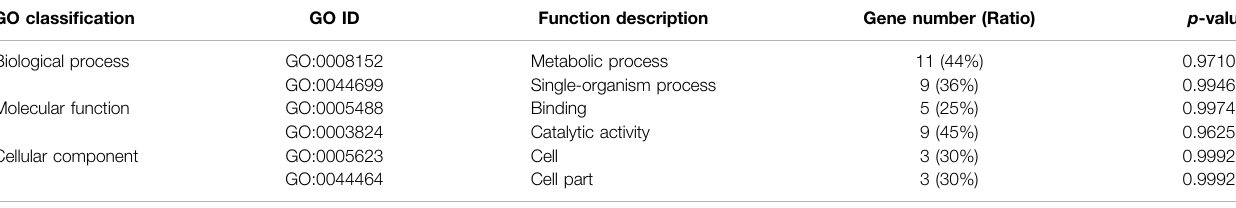
TABLE 8 | GO enrichment for strong positive select genes by comparing Bactrocera dorsalis (Hendel) and Ceratitis capitata (Wiedemann). GO classi fi cation